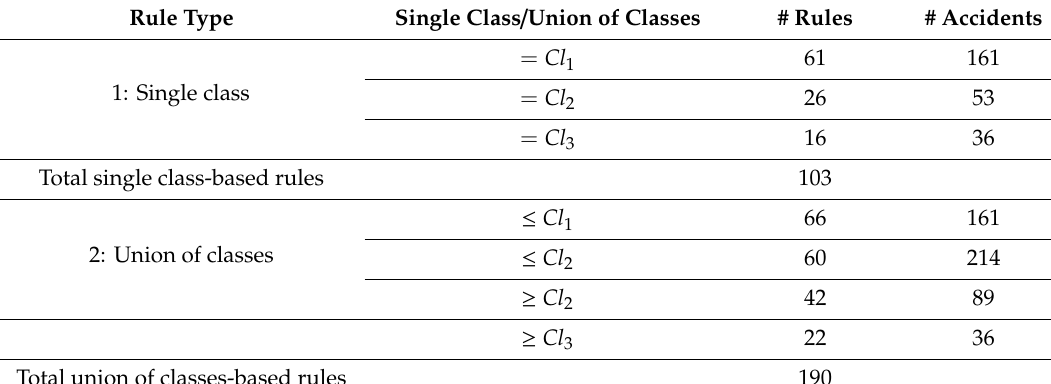
Table 3. Summary of decision rules obtained from the rough sets analysis of ENSAD